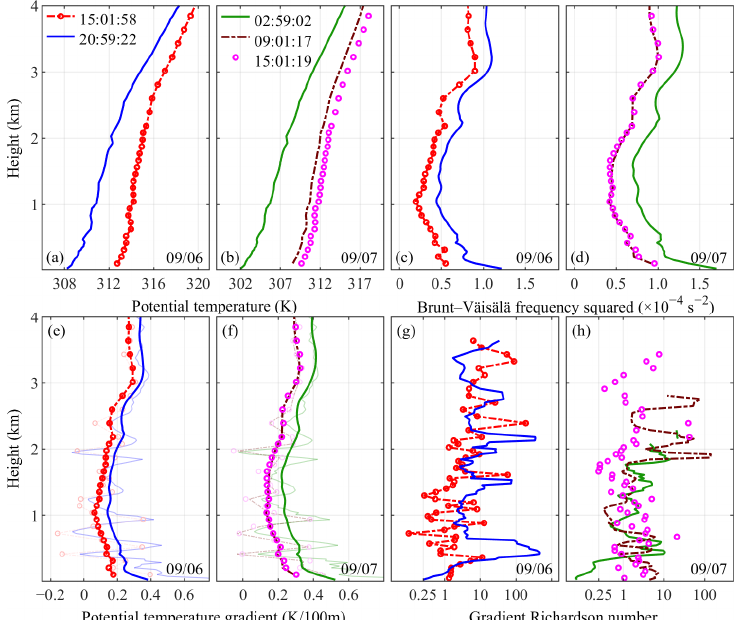
Figure 7. The results of potential temperature ( a , b ), potential temperature gradient ( e , f ), Brunt– Väisälä frequency squared ( c , d ), and gradient Richardson number ( g , h ) profiles derived from CDWL, MWR, and the barometric formula at different times on 6–7 September 2019, local time.